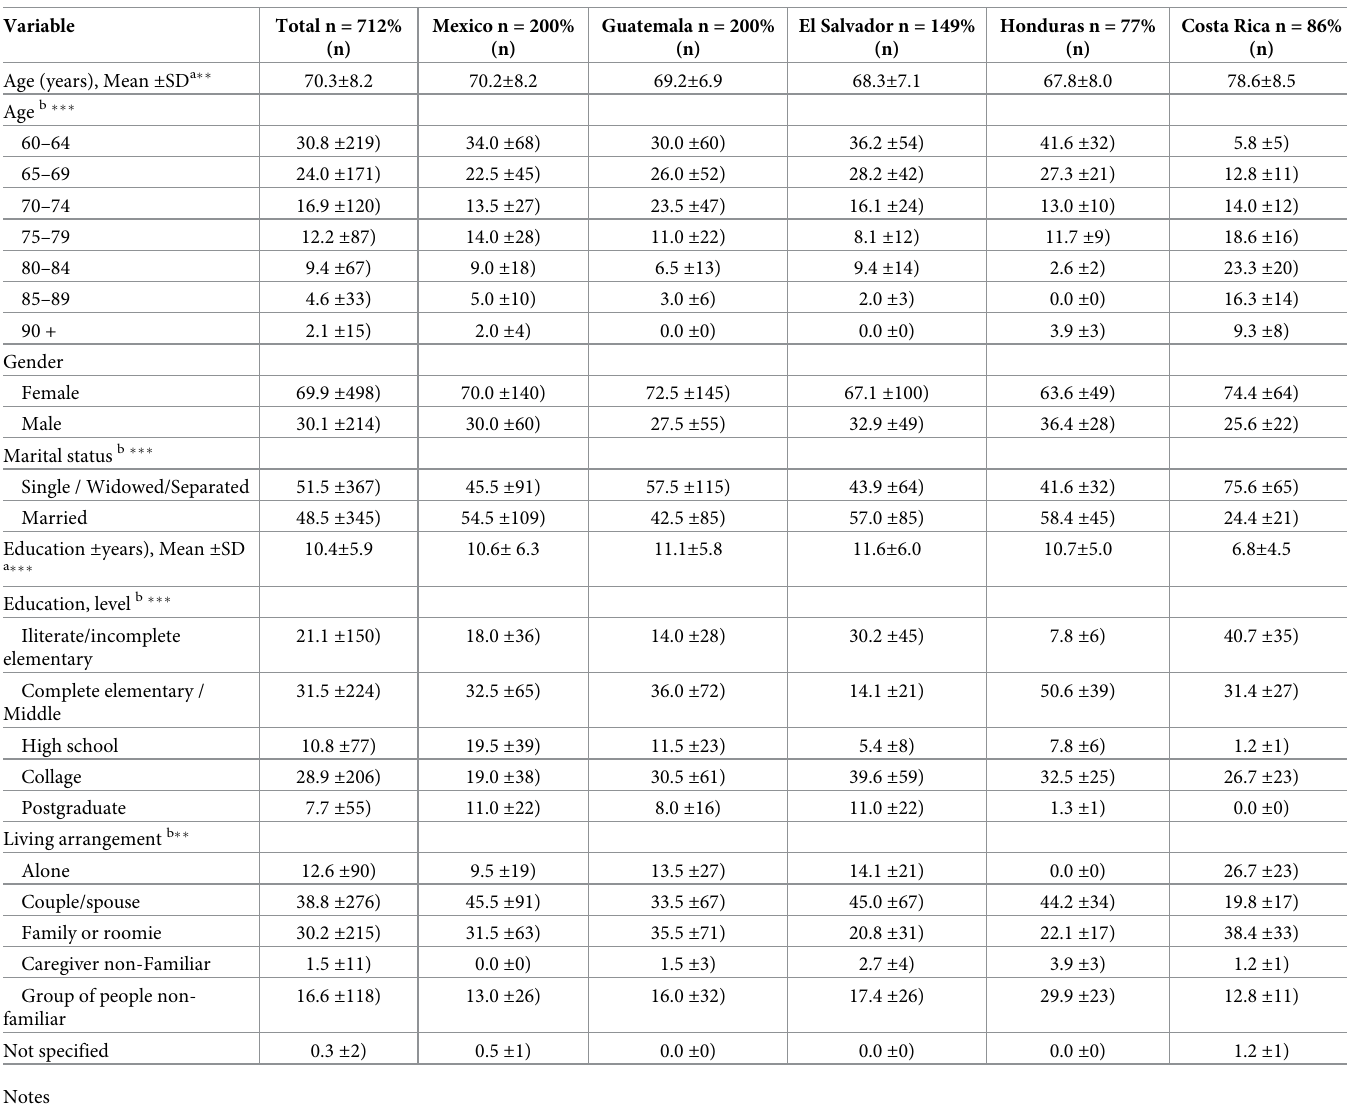
Table 1. Socio-demographic data of